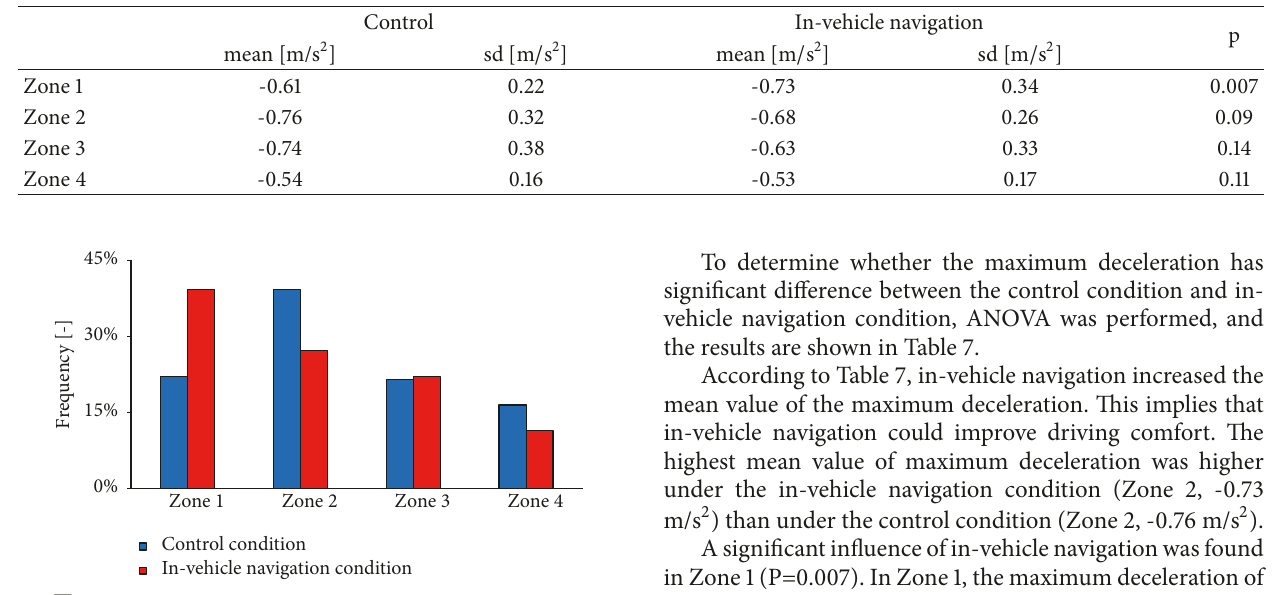
Table 7: Statistical results of the maximum deceleration.